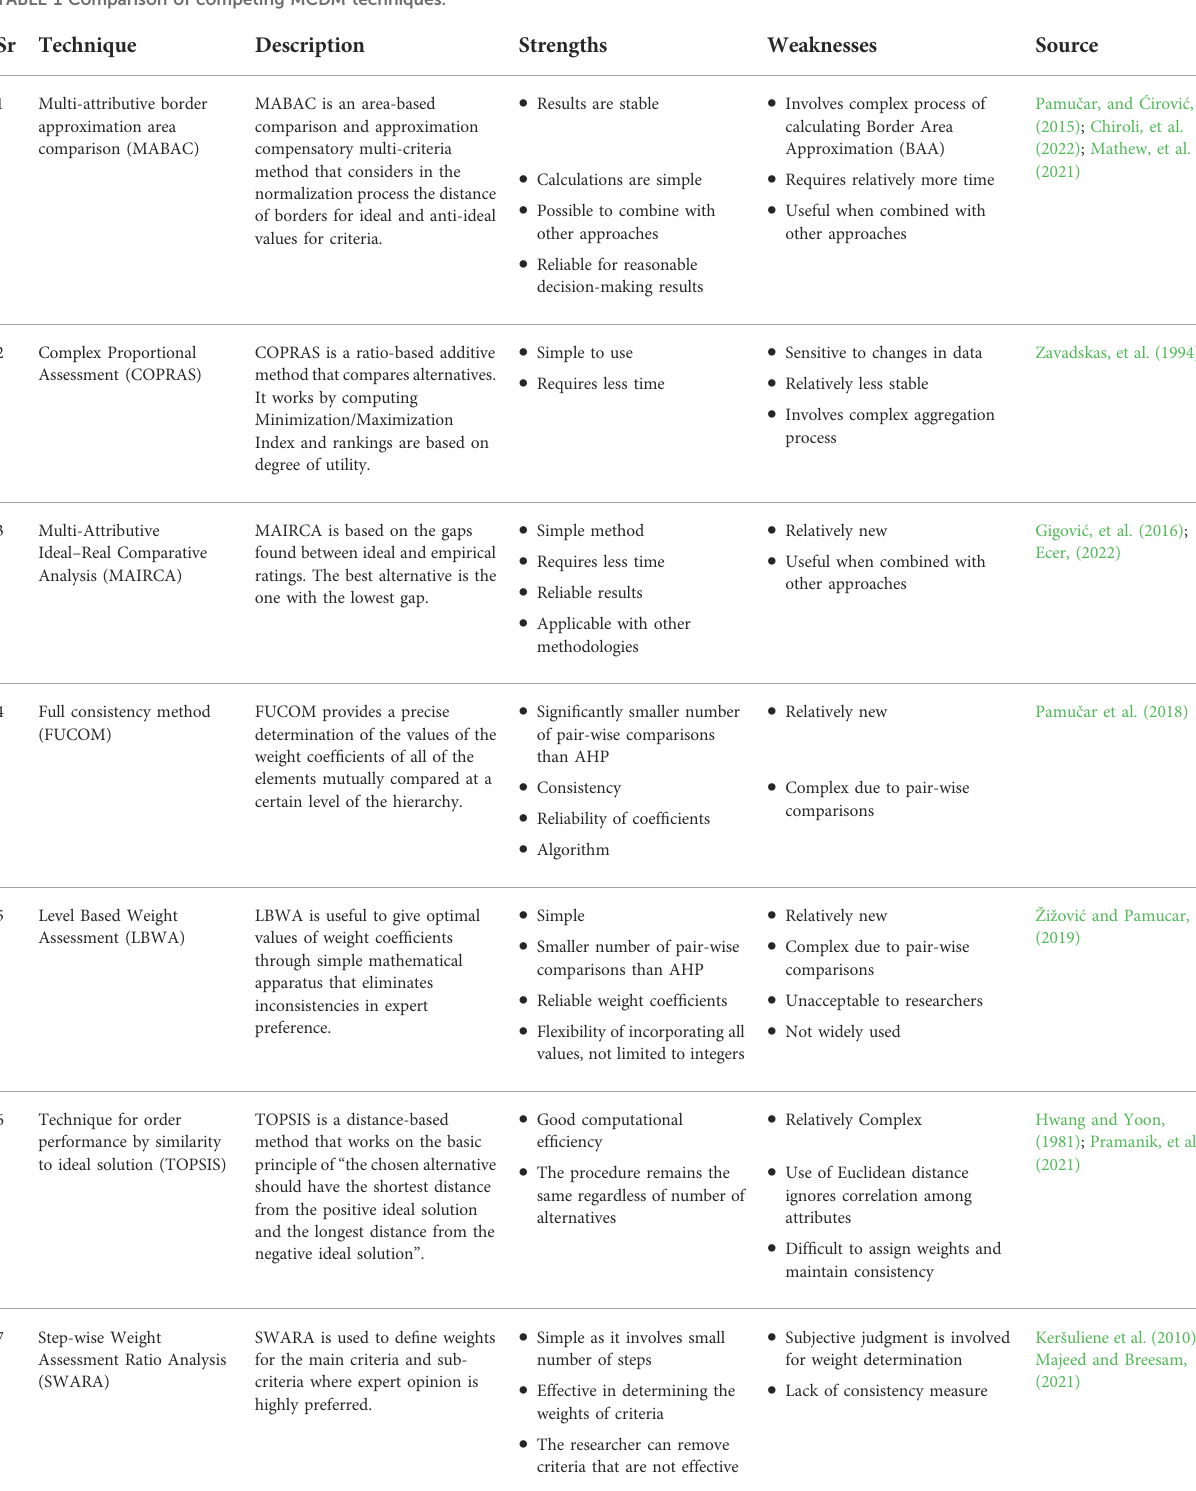
TABLE 1 Comparison of competing MCDM